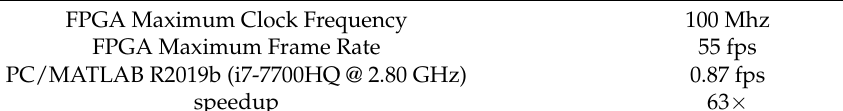
Figure 10. Test result in the glare scene. ( a ) Infrared image; ( b ) Visible image; ( c ) Fused image on FPGA; ( d ) Fused image on PC.